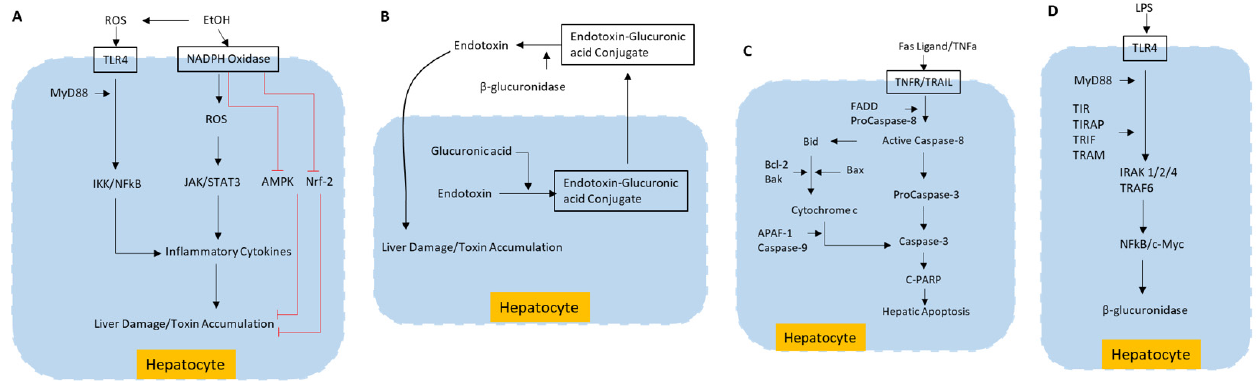
Figure 2. Molecular pathways of liver toxicity. ( A ) ROS production resulting from exogenous toxins, such as alcohol, inducing liver damage by apoptosis; ( B ) Liver damage caused by deconjugation of endotoxins; ( C ) Death receptor-mediated signaling pathway in liver cells inducing liver damage by apoptosis; ( D ) β - glucuronidase synthesis pathway induced by endotoxin LPS. EtOH—Ethanol; ROS—Reactive oxygen species; TLR4—Toll like receptor 4; NADPH—Nicotinamide adenine dinucleotide phosphate; MyD88—Myeloid differentiation primary response 88; IKK—I κ B kinase; NFkB—Nuclear factor kappa-light-chain-enhancer of activated B cells; JAK—Janus kinase; STAT3—Signal transducer and activator of transcription 3; AMPK–5’—AMP-activated protein kinase; Nrf-2—Nuclear factor erythroid 2–related factor 2; TNFa—Tumor necrosis factor-alpha; TNFR—TNF receptor; TRAIIL—TNF-related apoptosis-inducing ligand;